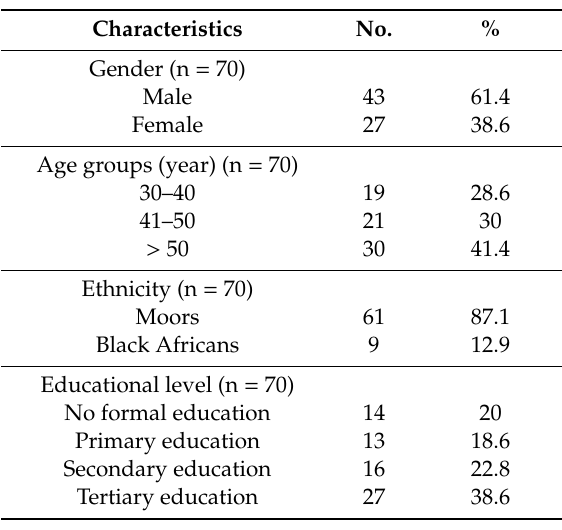
Table 4. Sociodemographic characteristics of the 70 participants in the ethnobotanical survey from Nouakchott, Mauritania, Northwest